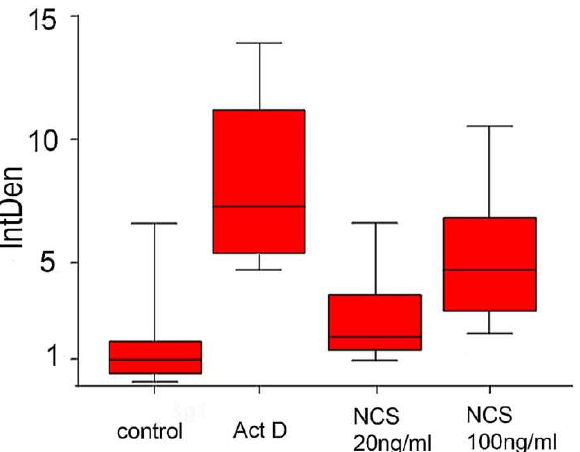
Figure 14. Quantification of TUNEL signal intensity in control, actinomycin D-treated blastocysts, and blastocysts after previous treatment with NCS during one-cell stage. The values show the average relative density of the fluorescent signal in the blastocyst of each experimental group.